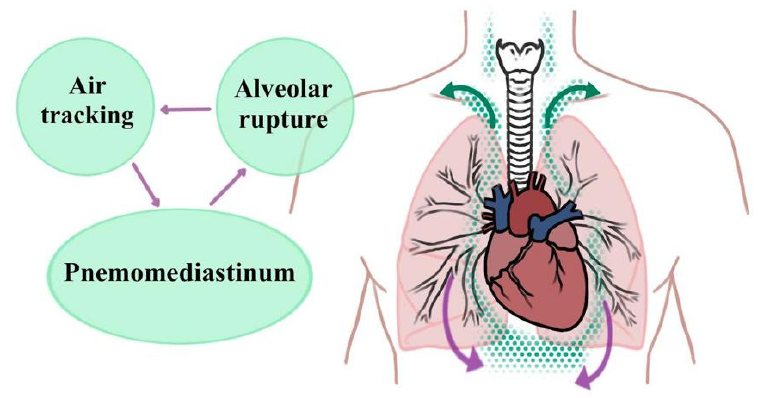
Figure 4. Extending beyond the pulmonary hilum.